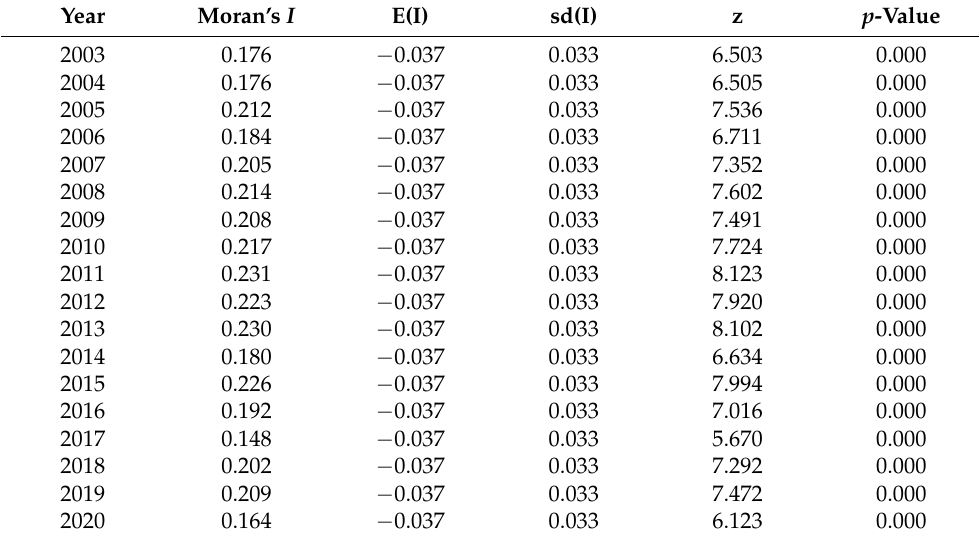
Table A1. Moran’s I of PM 2.5 pollution in the urban agglomerations in the middle reaches of the Yangtze River based on geographical distance weight